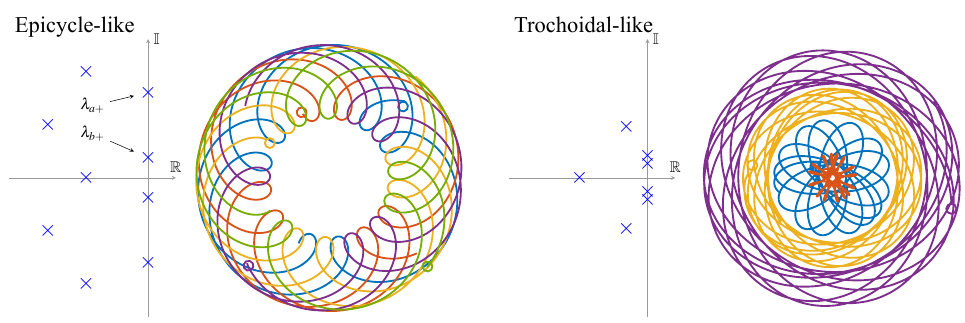
Figure 2. Examples of eigenvalue repartition and the corresponding pattern of